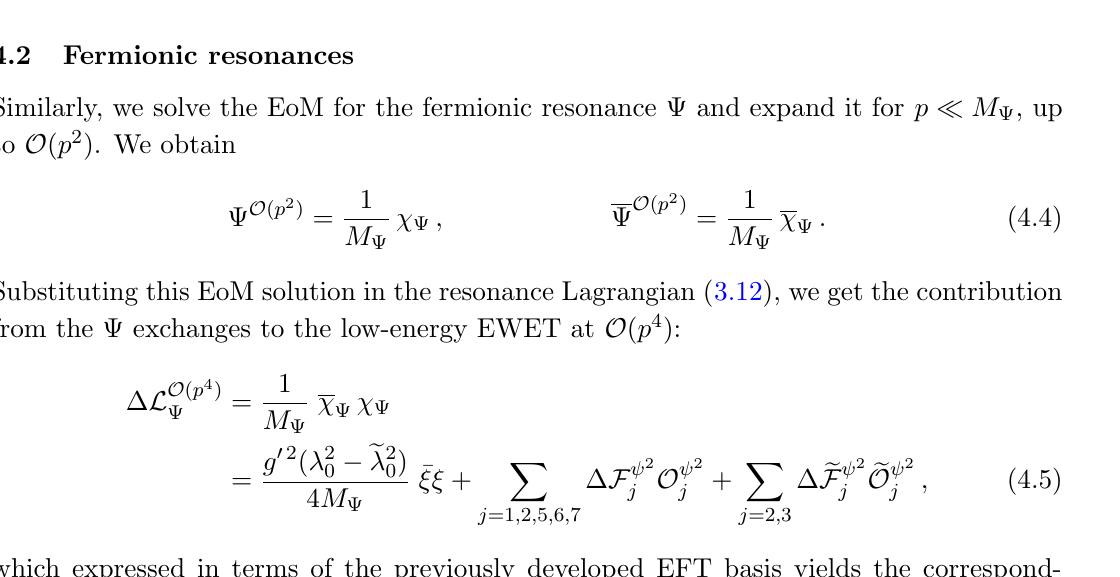
Table 4 . Contributions to the O ( p 4 ) LECs of two-fermion P -even operators from heavy scalar, pseudoscalar, vector, axial-vector and fermionic